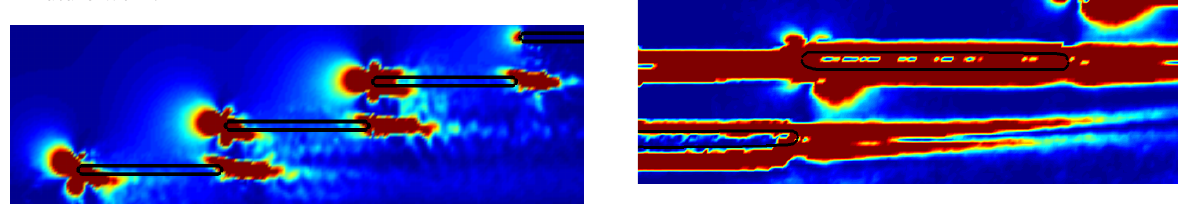
Fig. 5. Computed steady velocity field